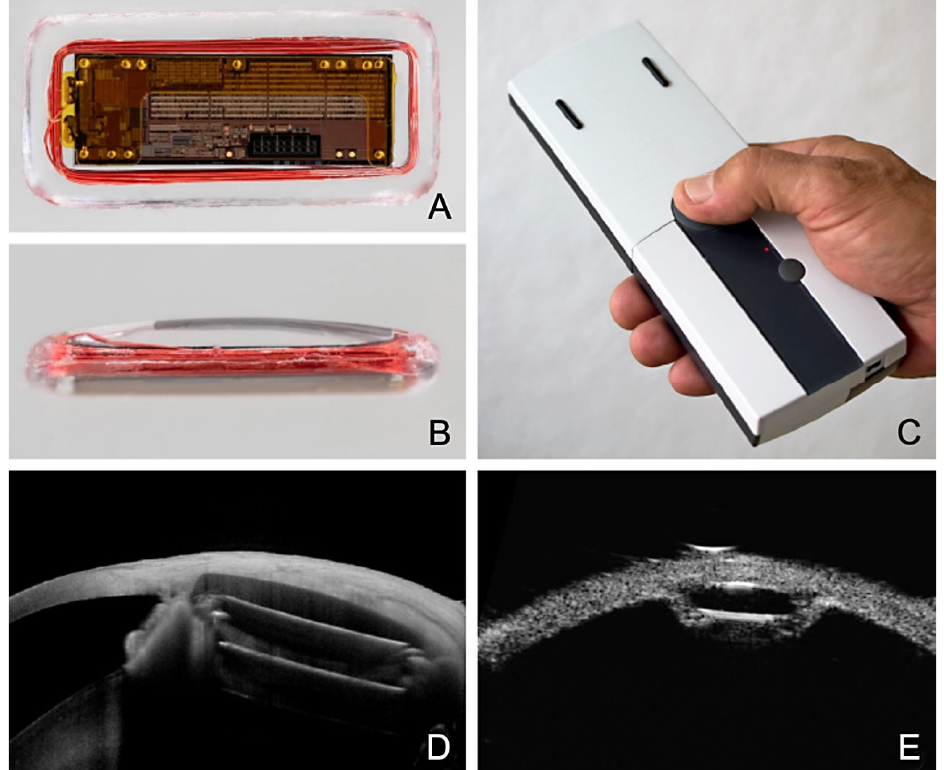
Figure 8. Eyemate-SC sensor looking at the electronics from ( A ) the top and ( B ) the side. ( C ) Meso- graph readout device for wireless telemetric IOP measurement. Multimodal imaging 6 months after suprachoroidal implantation of the Eyemate-SC sensor. ( D ) An anterior segment (AC)-OCT visual- izes the microelectronics carrier substrate, but not the silicone encapsulation. ( E ) The UBM image (50 MHz) depicts the lens-shaped rounded silicone encapsulation smoothly adapting to the curved scleral shape. The Eyemate-SC IOP sensor delivers a wireless readout of continuous IOP values. The Mesograph handheld device can store up to 3000 IOP readings. The data can be wire- lessly transferred to a secure, web-based platform accessible to the supervising ophthal- mologist. Since each measurement is stored with a time stamp, patients can automatically create their individual IOP pro fi le to disclose short- and long-term fl uctuations and, if necessary, the therapy can be adapted accordingly [53]. Thus, supervising ophthalmolo- gists can base their therapy decisions on a broad database of many hundreds of measure- ments instead of only a few measurements per year. Telemetric self-measurement using an intraocular sensor also has other advantages. The measured values correspond to the true IOP independently of the corneal